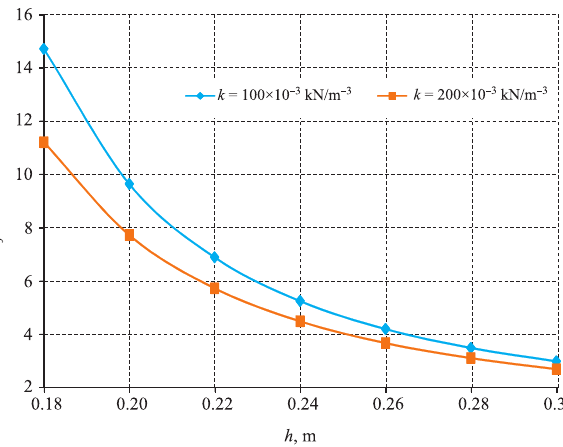
Fig. 1. Equivalent axle load factors F j and exponents n in relation obtained from various fatigue criteria as a function of actual axle load Q j (for h = 0.26 m, R b = 5.5 × 10 3 kN/m 2 , E = 35 × 10 6 kN/m 2 ; k = 100 × 10 3 kN/m 3 , Q s = 100 kN)